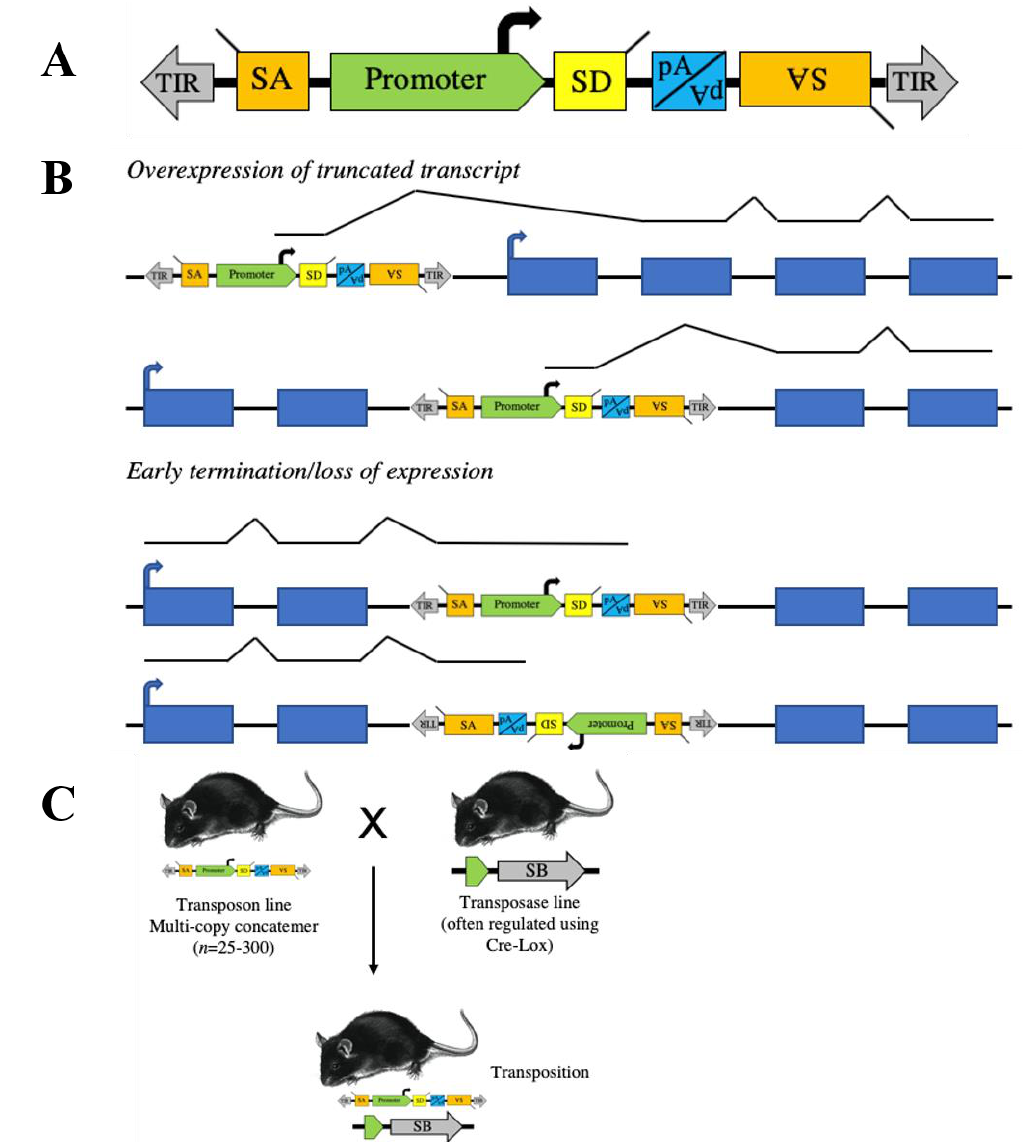
Figure 1. Sleeping Beauty (SB) transposons can be designed to randomly induce somatic cell gain and loss of function mutations. ( A ) Structure of a proto-typical transposon vector for somatic cell or cell line mutagenesis studies. A strong promoter followed by an exon with a splice donor (SD) is present to activate transcription of downstream exons. Splice acceptors (SA) and a bi-directional polyadenylation site (pA) are included to disrupt gene expression. ( B ) In mutagenized cells, transposons can activate endogenous proto-oncogenes or disrupt endogenous tumor suppressor genes depending on where insertion occurs and in what orientation. ( C ) Transposon transgenic mice are usually produced by standard pronuclear injection resulting in the generation of lines with multicopy concatomers. These are crossed to mice expressing the transposase to generate mice with somatic cell transposition.